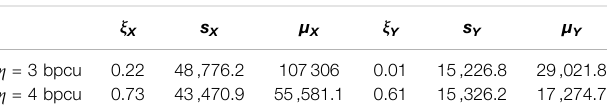
TABLE 3 | PDF approximation